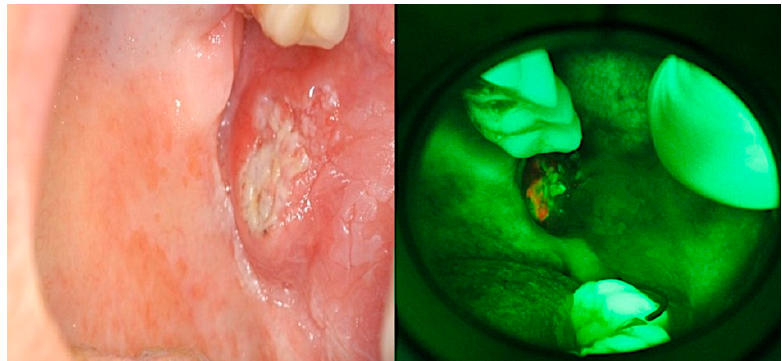
Figure 3. Clinical appearance of the painful suspected lesion on the right buccal mucosa in a 63-year-old female smoker patient and appearance of the VelScope exam of the same lesion characterized by LAF and associated red/orange coloring typical of secondary bacterial contamination.